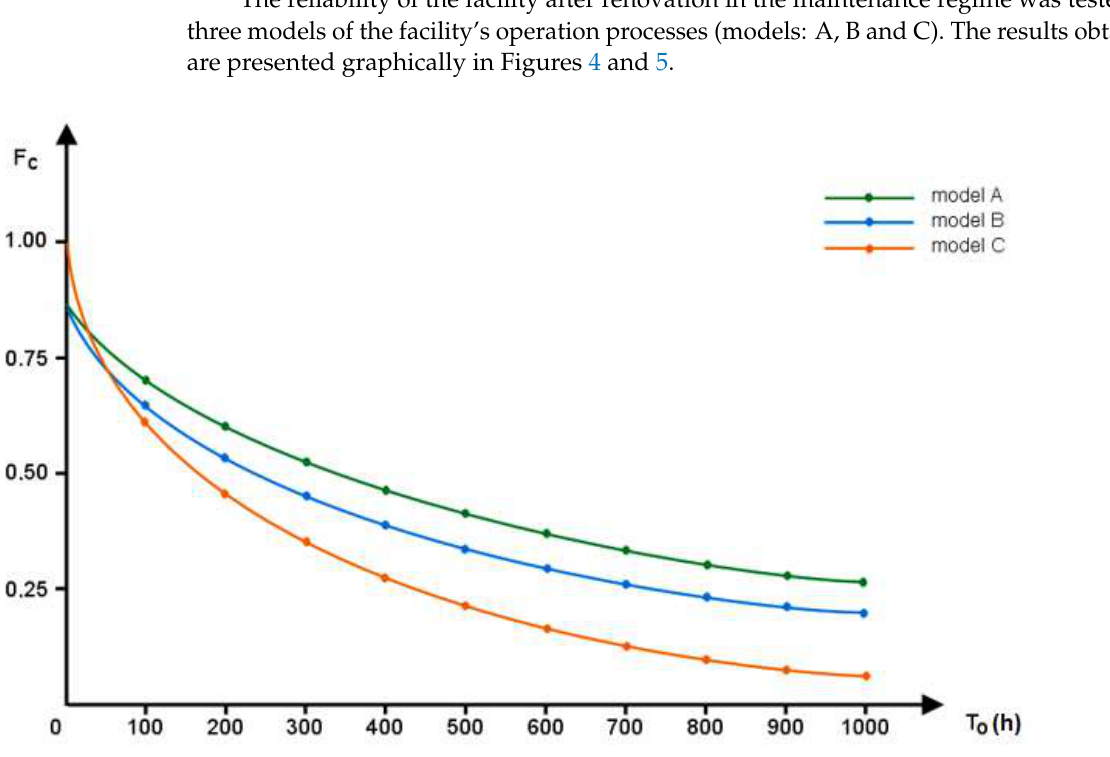
Figure 5. Graph of the use quality function Fc for the models tested (A, B and C) of the wind farm devices in the operation process, where: To—is the time of the operational process. devices in the operation process, where: To—is the time of the operational